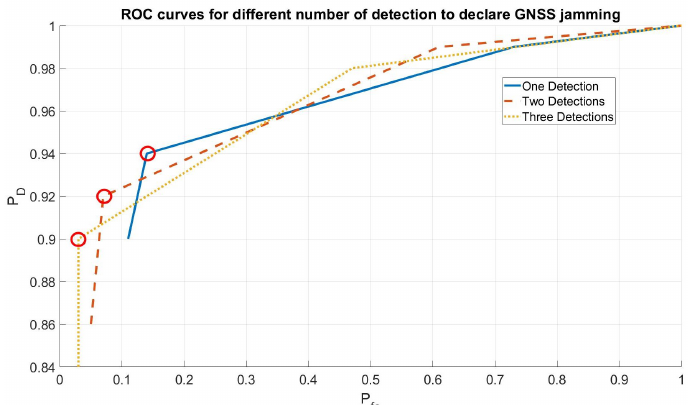
Figure 5. Receiver Operating Characteristic for different numbers of detections.